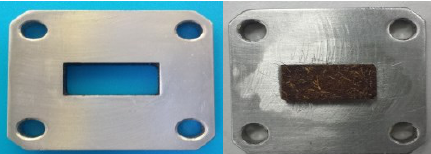
Figure 1: The sample holder used as rectangular mould with dimension of length 22.860 mm and width 10.160 mm